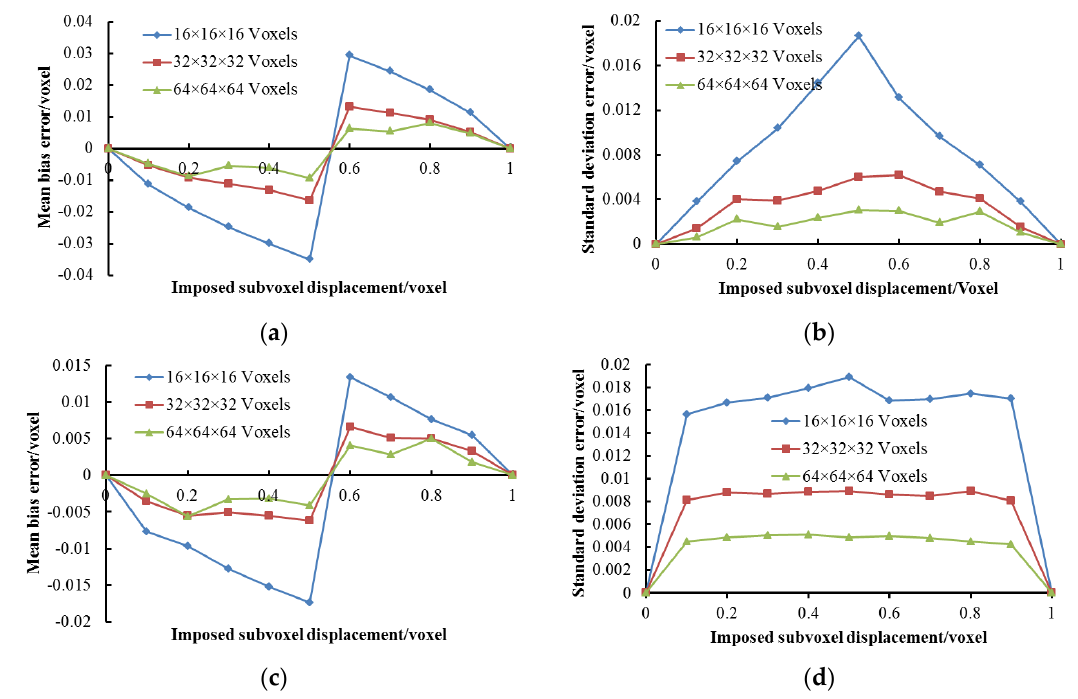
Figure 12. Comparison of displacement resolution among different sizes of subset. ( a ) Mean bias error of the red sandstone specimen; ( b ) Standard deviation error of the red sandstone specimen; ( c ) Mean bias error of the woven specimen; ( d ) Standard deviation error of the woven composite specimen.